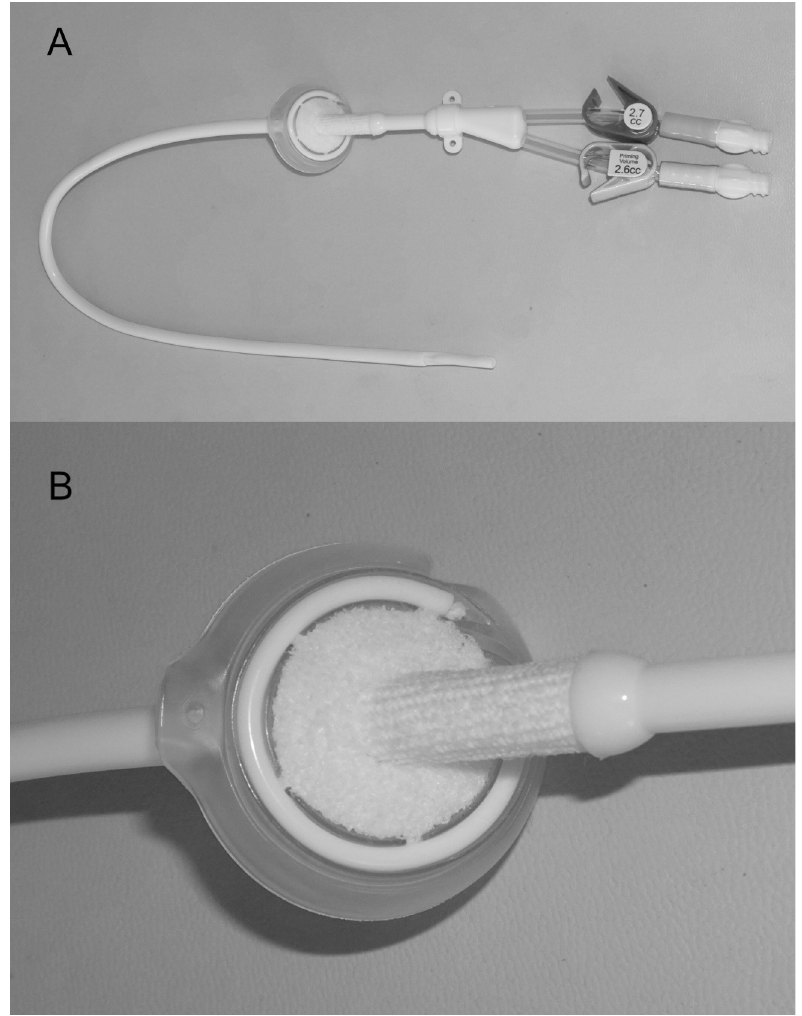
Fig 1. The NexSite HD Catheter showing A) the entire assembled catheter with B) a close-up view of the attached Dermal Ingrowth Support Collar (DISC).